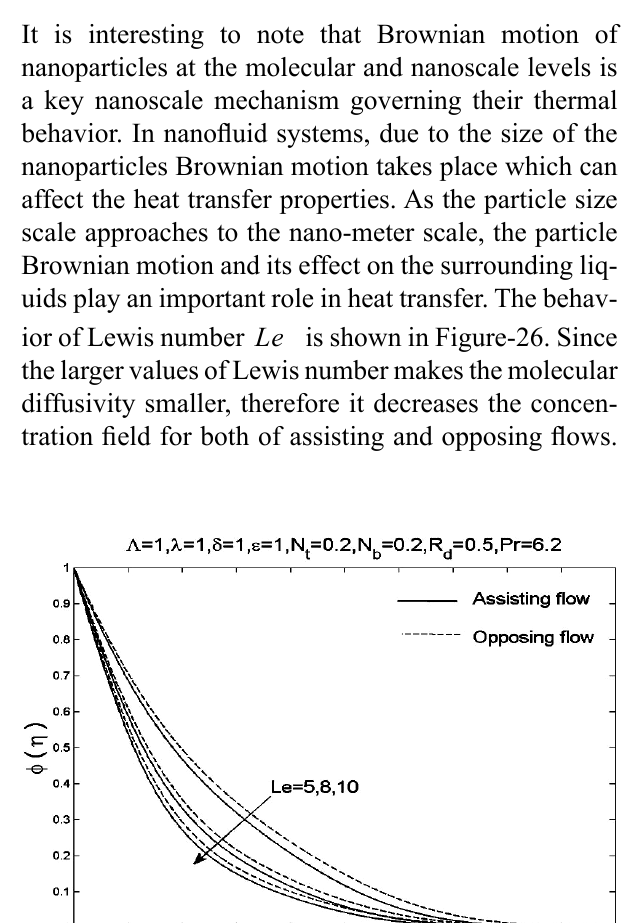
Fig. 25. The effect of the Brownian motion parameter Nb on the concentration profiles ( ) φη .